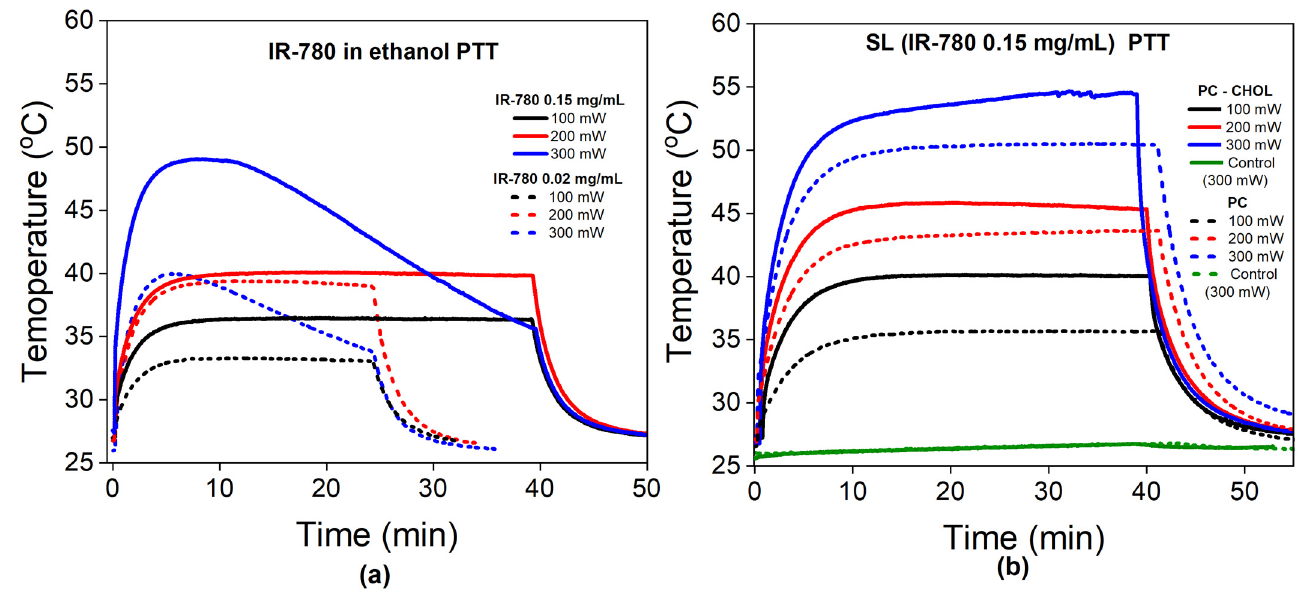
Figure 3. Photothermal study: ( a ) Temperature profile during PTT with free IR-780 in different amounts (0.02 and 0.15 mg/mL) and at different laser powers (100, 200 and 300 mW). Solid and dashed lines correspond to high and low IR-780 contents, respectively. ( b ) Temperature profile during PTT for synthetic liposomes containing a concentration of IR-780 of 0.15 mg/mL. Dashed lines represent SLs without cholesterol, while solid ones represent those with cholesterol.